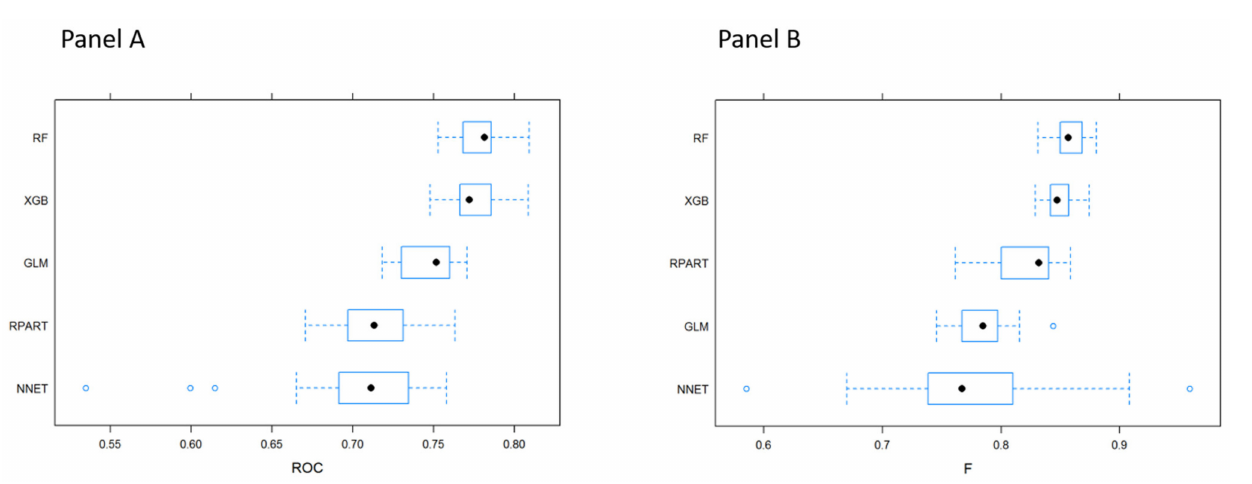
Figure 1. Comparison of the performance of the MLT algorithms. (Panel A ) presents the ROC. (Panel B ) presents the F-score